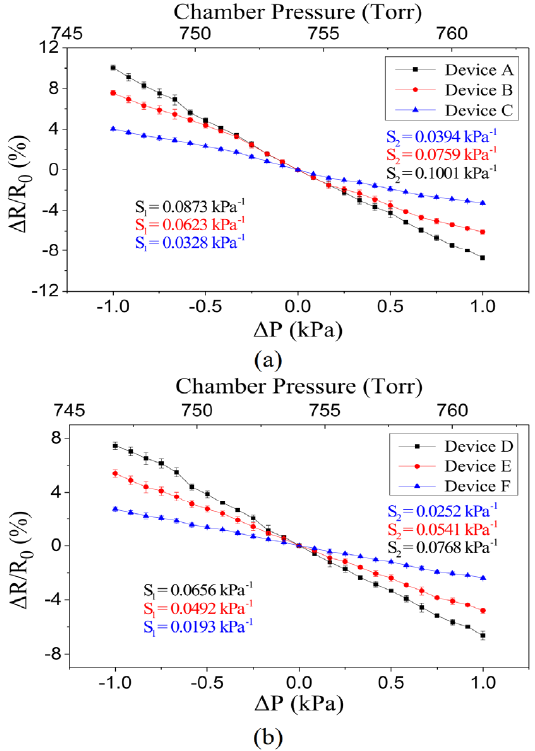
Figure 8. ( a ) Comparison of devices with different film thickness in 7.5 mm cavity. ( b ) Comparison of devices with different film thickness in 6.0 mm cavity. Table 1. Dimensions of the fabricated sensors.